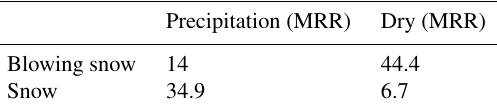
Figure 12. Precipitation occurrence as a function of the threshold on precipitation intensity for the full year (top) and summer period (bottom) respectively. The precipitation occurrence timescale is 6h. Table 4. Contingency table between the occurrence of near-ground (300m) MRR signal (columns) and visual observations of snow and blowing snow conducted by Météo France (rows). A threshold on the MRR data of 10 − 2 mmh − 1 is used to discriminate between dry sky and precipitation. The elements of the contingency table are nor- malized to the total number of observations and sum up to